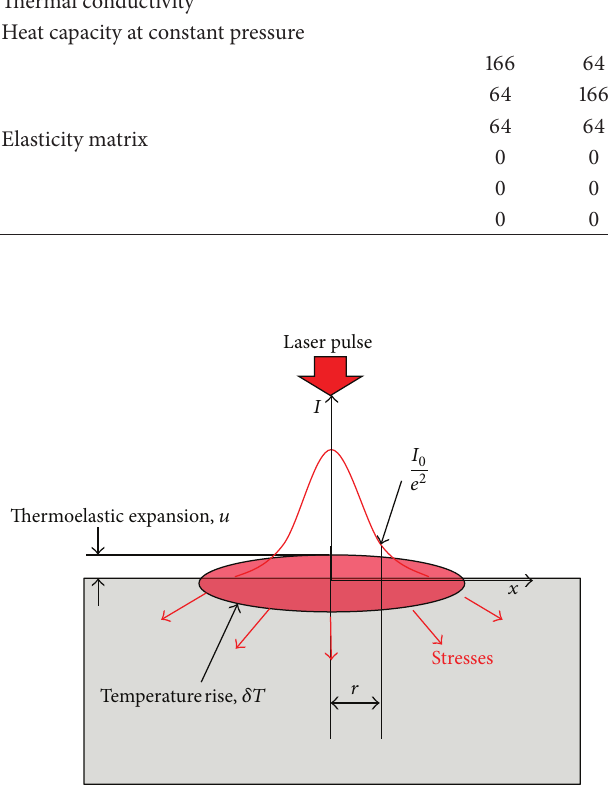
Figure 2: Schematic of thermoelastic mechanism.